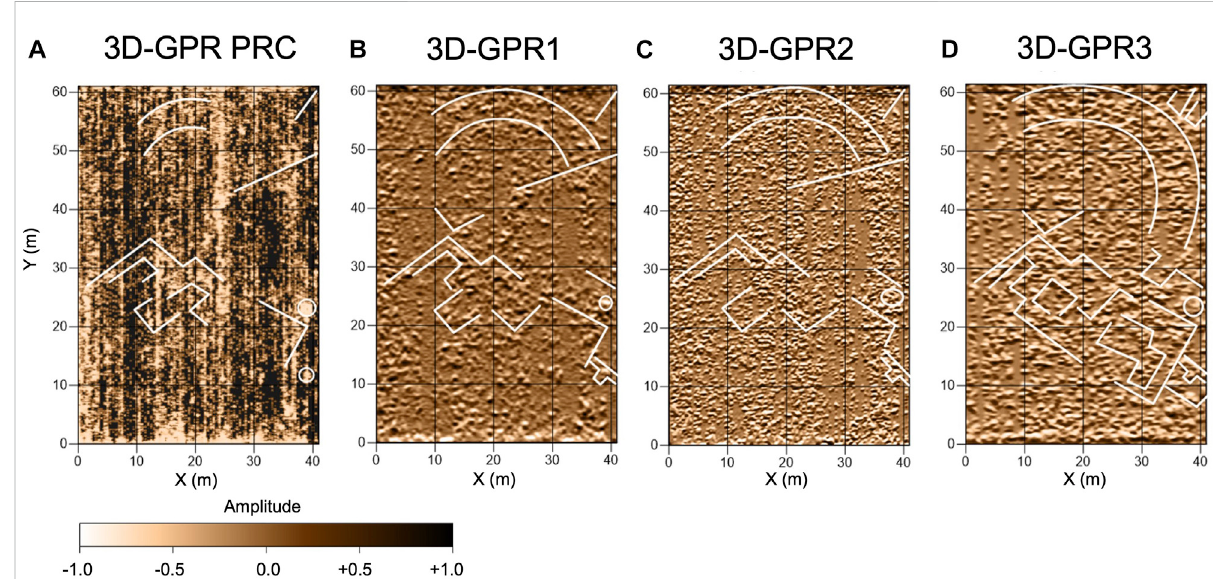
FIGURE 7 Cover surfaces of the results obtained by the advanced processing of the 3D-GPR datasets of sector A1 of Pisões. (A) 3D-GPR PRC, resulting from standard processing. (B) 3D-GPR1, resulting from application of the directional fi lter. (C) 3D-GPR2, resulting from data densi fi cation. (D) 3D- GPR3, resulting from noise removal in the spectral domain. Interpretive lines were drawn on all surfaces, from the most signi fi cant alignments, to facilitate their